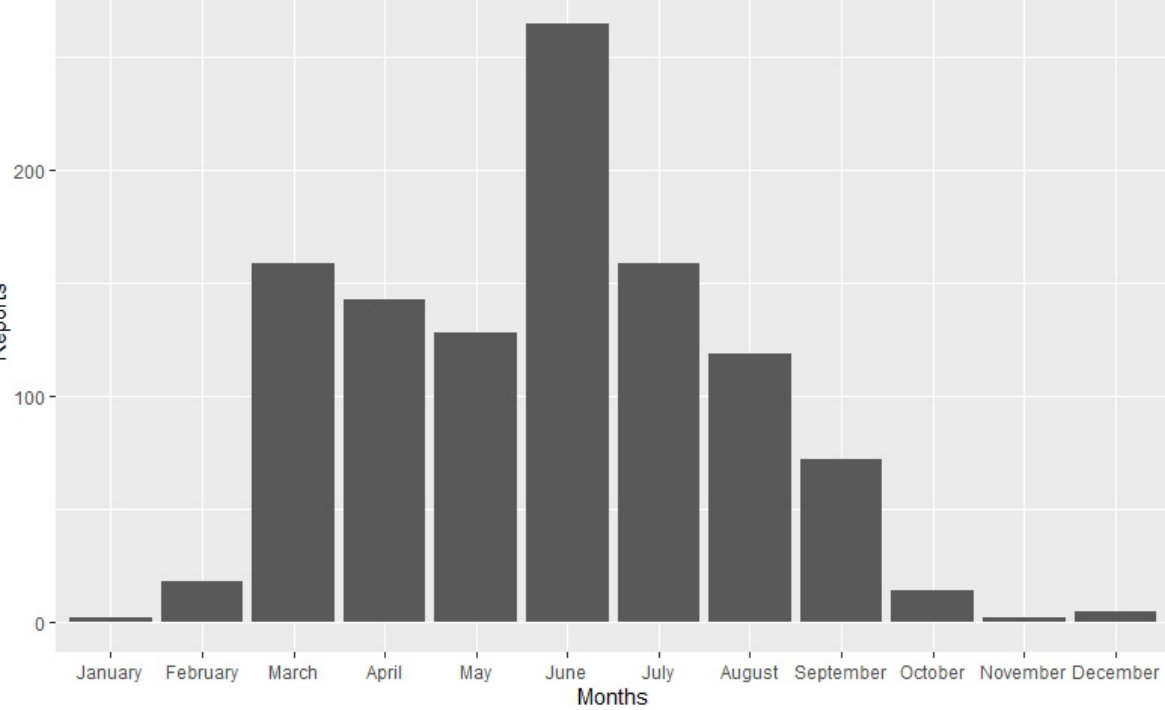
Figure 4. Number of reports along the months in the two years of the project.